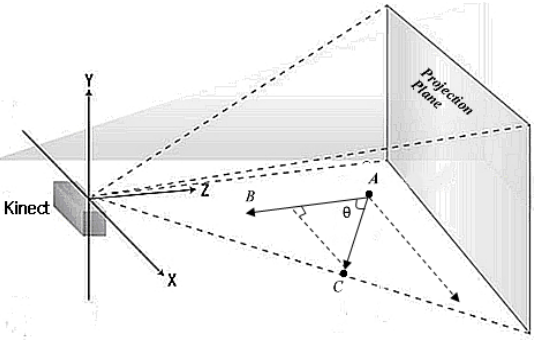
Figure 11. Estimation of view angles for 2.5D gait.